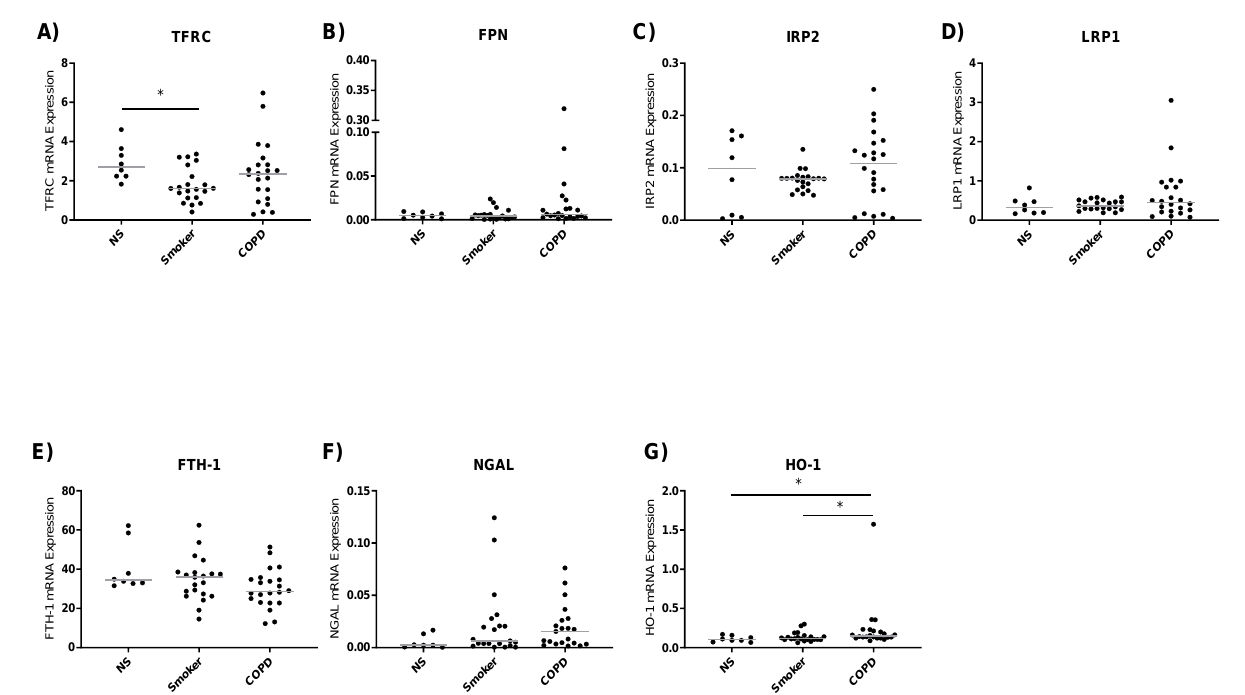
Figure 2. Baseline lung macrophage iron metabolism gene expression. Real-time qPCR was used to assess levels of TFRC, FPN, IRP2, LRP1, FTH-1, NGAL and HO-1 expression of lung macrophage from non-smoker (NS) ( n = 8), smoker (S) ( n = 24) and COPD ( n = 27) ( A – G ). Expression levels are relative to GAPDH (2 − ∆ Ct ). Data presented as individuals with median. Kruskal–Wallis multiple comparisons test was used to test differences between groups. * = p < 0.05.